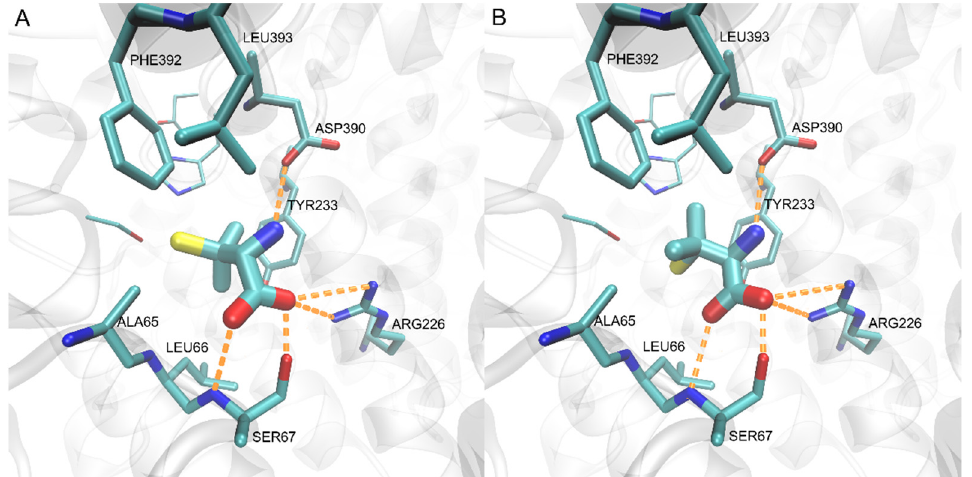
Figure 7. Results of docking for L- ( A ) and D-penicillamine ( B ) to the active site of the modeled Ca Met2p. The bound ligands are depicted with thick sticks, and the neighboring active site residues with regular sticks. Catalytic triad comprising of Ser 154 , His 389 , and Asp 360 sidechains is visible in the background of the binding site, and is drawn with the thinnest sticks. Hydrogen bonds are represented by orange dashed lines.